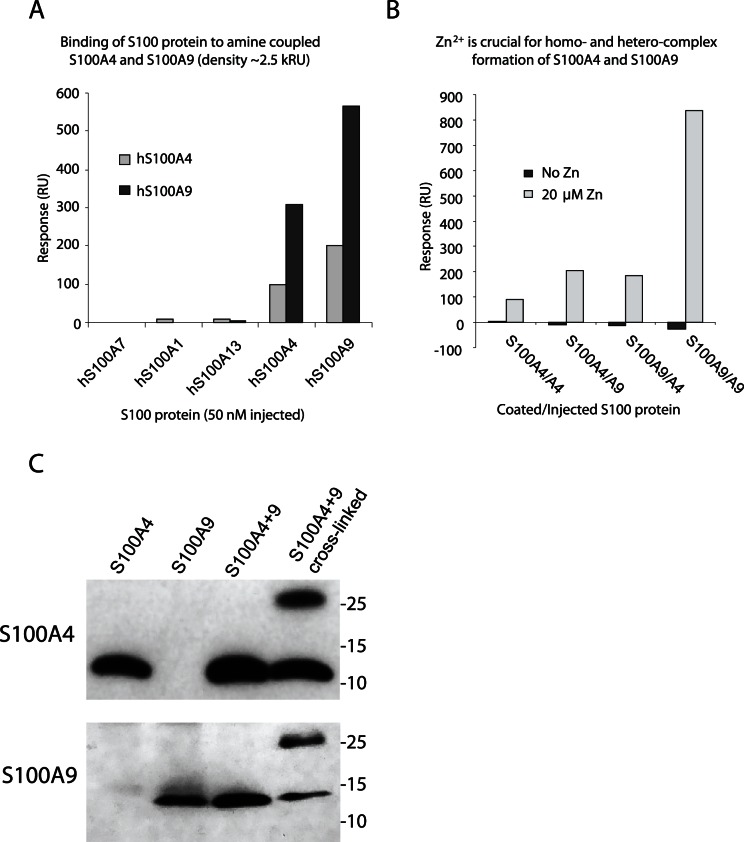
S100A4 and S100A9 can form heterodimers.A: Binding of S100 proteins to immobilized S100A4 and S100A9. S100A1, A4, A7, A9 and A13 (∼1.3 µg/mL) were injected (2 min at 30 µL/min) over S100A4 and S100A9 (density ∼2.5 kRU) in the presence of 1 mM Ca++ and 20 µM Zn++. Responses were calculated at late association phase. B: Formation of homo- and hetero-complexes of S100A4 and S100A9 is Zn++ dependent. S100A4 and S100A9 were injected over immobilized S100A4 or S100A9 at ∼1.3 µg/mL HBS-P containing 1 mM Ca++ ±20 µM Zn++. Responses at late association phase were calculated. C: HEK293T cells were transfected either with S100A4 or S100A9 cDNA construct alone or the two together, as indicated. After 24 hrs of culture some of the transfected cells were exposed to the membrane permeable cross-linker DSS. Thereafter cell lysates were prepared, equal amounts (30 µg) of protein loaded on an SDS-PAGE gel and western blots were performed using either anti-S100A4 or anti-S100A9 antibodies as indicated. Representative results from one out of two experiments performed are shown.